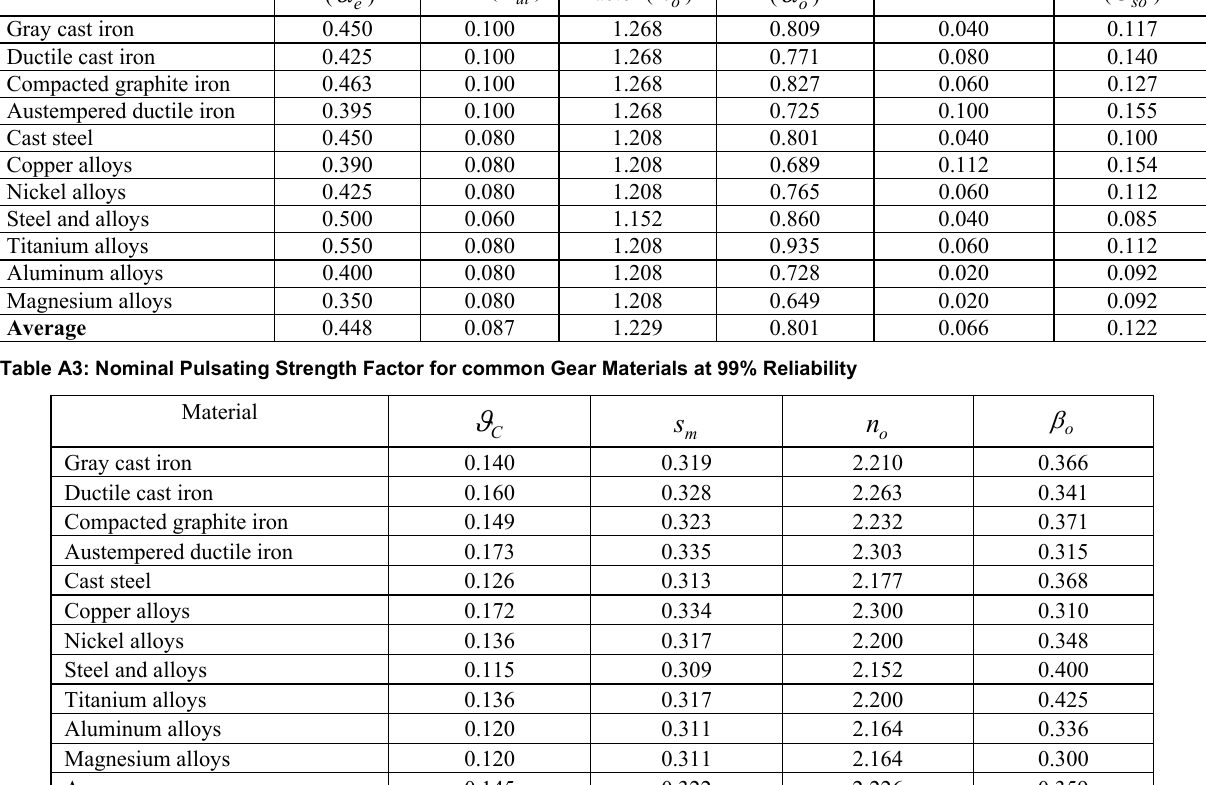
Material Gray cast iron